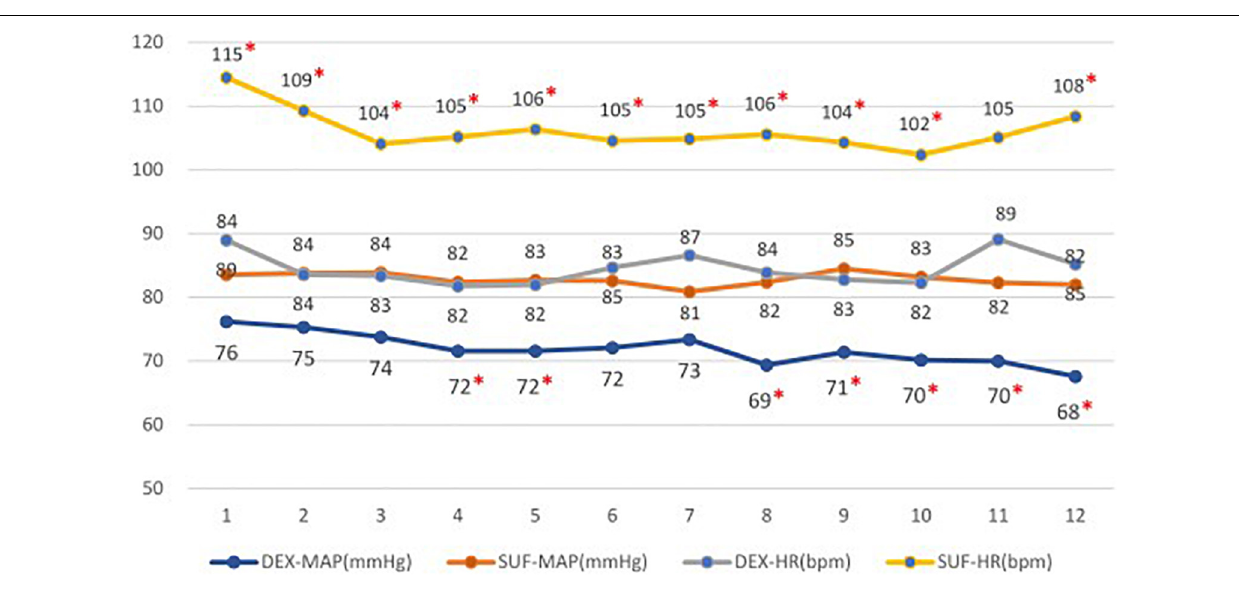
FIGURE 4 | Heart rates (HR) and mean arterial pressure (MAP) in patients aged > 6 years old in the SUF and DEX experimental groups. ∗ P < 0.05, from the comparison between the SUF and DEX